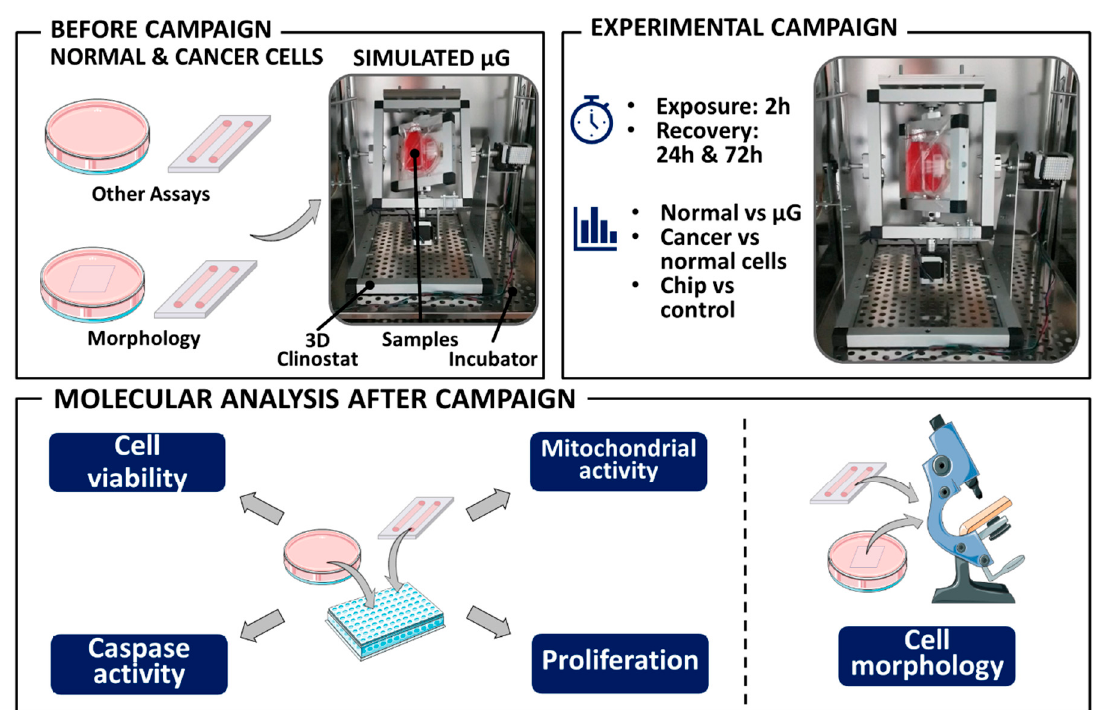
Figure 7. The schematic representation of the procedure of simulated microgravity experiment.